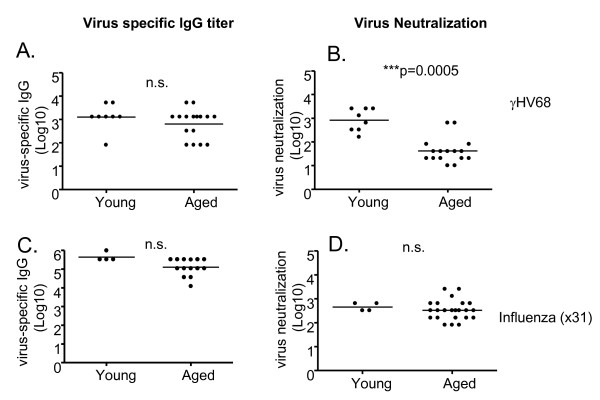
Serum titers of γHV68-specific antibody are maintained in latently infected mice with age, but serum neutralization activity wanes. The titers of virus-specific IgG were measured in the serum of latently-infected young (1-3 months p.i.) and aged (18-22 months p.i.) by ELISA (Panel A). Neutralization activity (measured in the same sera samples as A) were determined using an in vitro neutralization assay (Panel B). As a control, antibody titers (C) and neutralization activity (D) were measured in serum taken from mice (young and aged, as above) previously infected with influenza virus ×31. Symbols represent serum antibody titers and neutralization activities measured for individual mice. Bars indicate the medians calculated from the data shown. Significance was assessed using the Mann-Whitney rank test (two-tailed, 95% confidence). Ns; not significant.